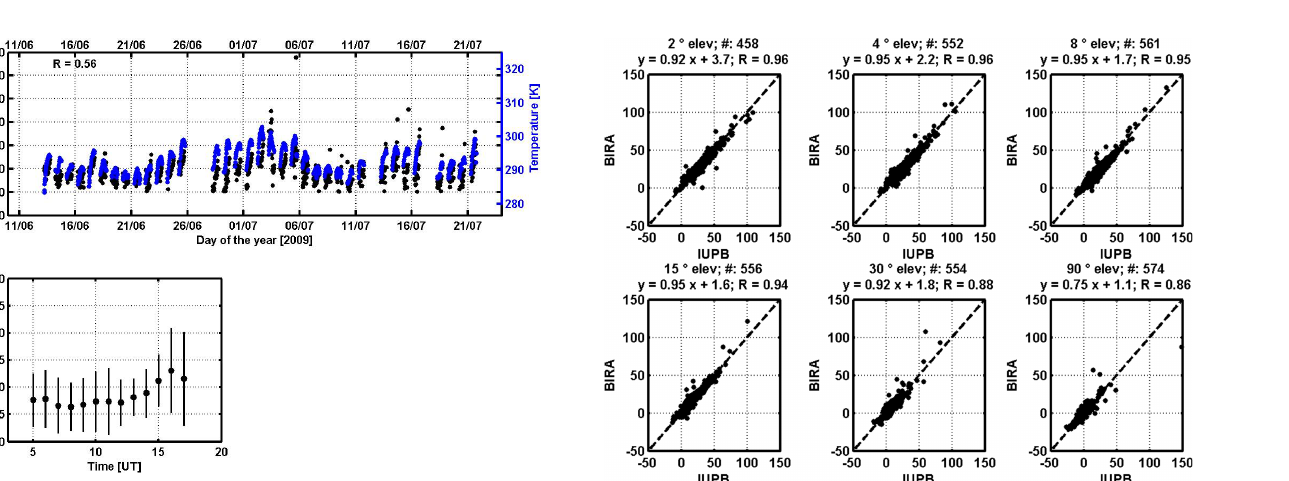
Fig. 5. Scatter plots of the HCHO DSCD (10 15 moleccm − 2 ) mea- sured by BIRA against those measured by IUP Bremen. Data from the whole campaign were averaged in 30-min bins. Statistical pa- rameters derived from each regression plot (number of points #, lin- ear regression equation and correlation coefficients R ) are given for each elevation above the corresponding subplots. The dashed line is the y = x